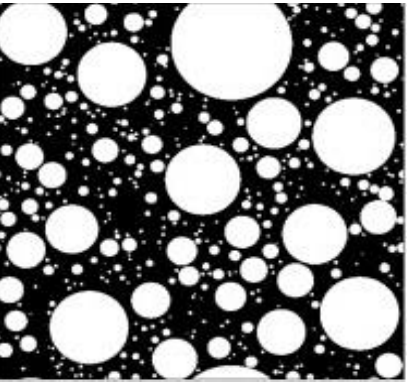
Figure 4. The 2D sketches of the initial paste microstructure [44].